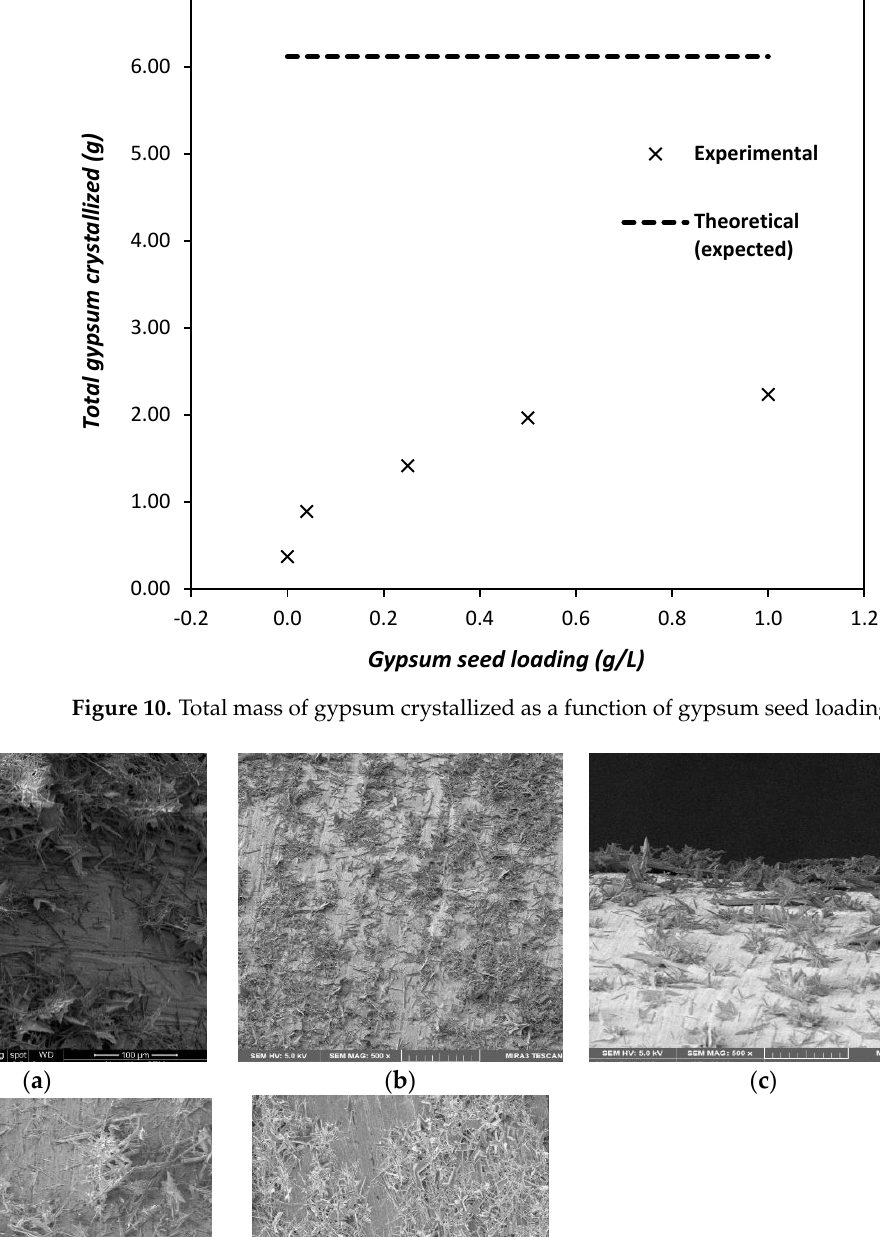
012345 Figure 12. Normalized gypsum scale growth rate as a function of seed loading. -0.2